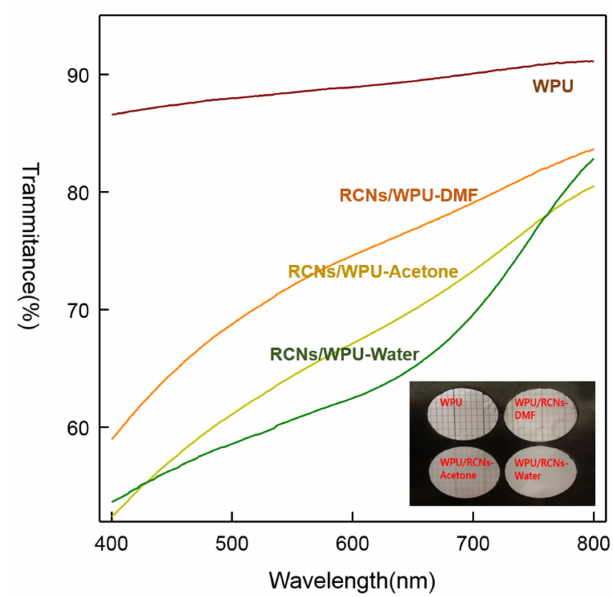
Figure 4. UV-visible spectrums of WPU, RCNs/WPU nanocomposites